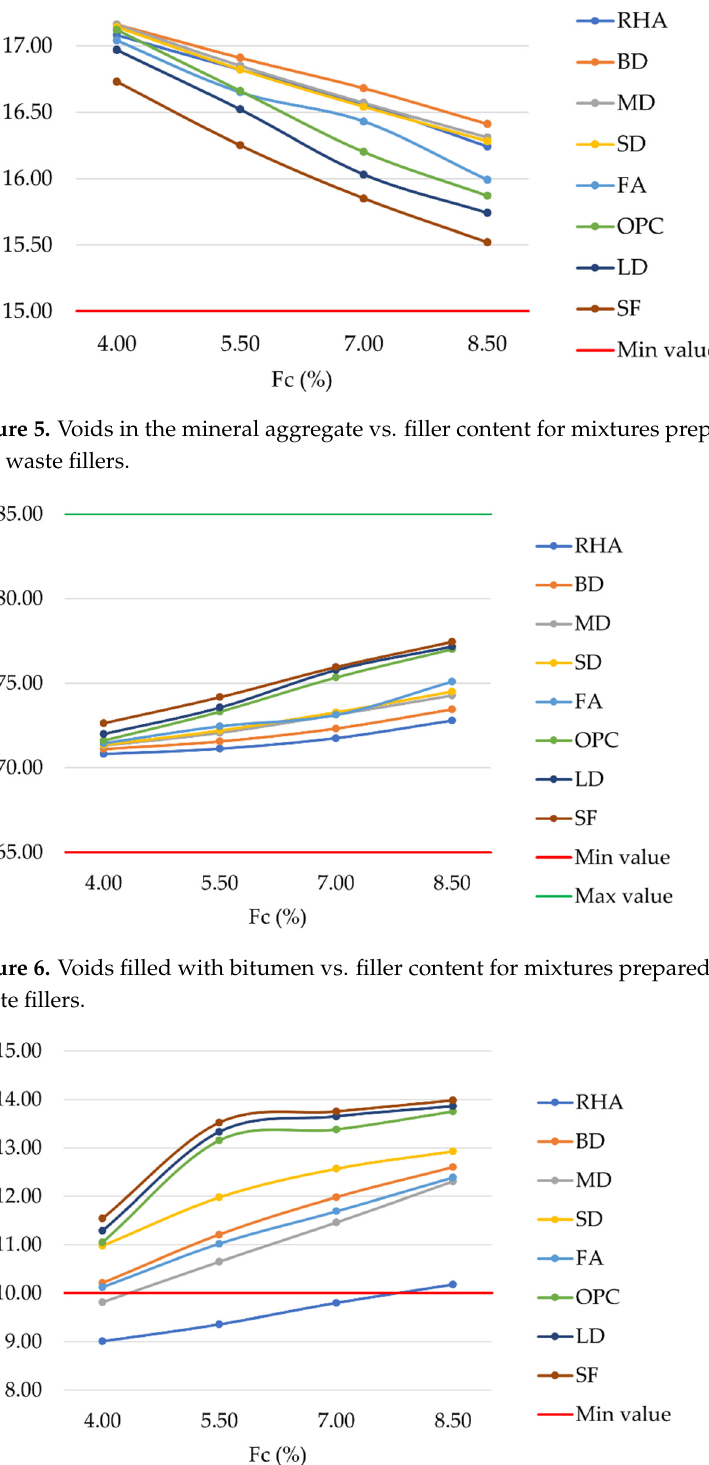
Figure 7. Marshall stability vs. bitumen content for mixtures prepared with conventional and waste fillers.